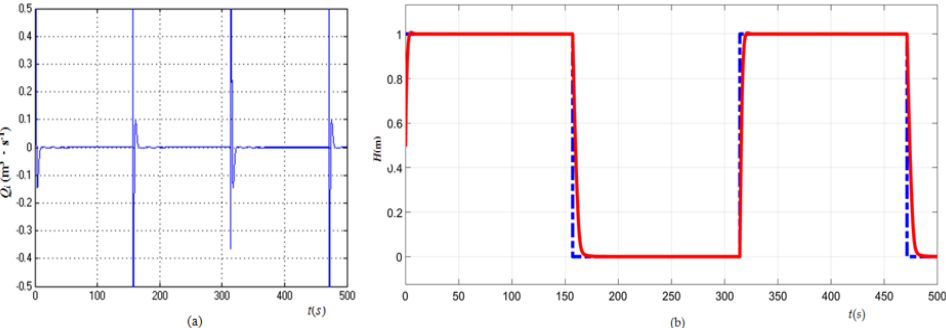
Figure 6. (a) and (b). Simulation results of linear feedback of the robust PID controller. The